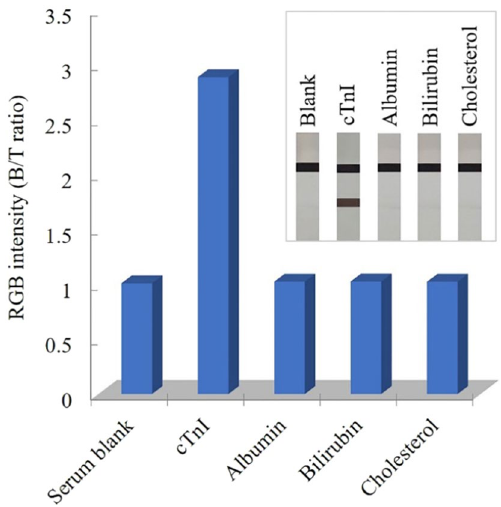
Figure 6. Bar graph and images of cross-reactivity test after silver enhancement, assessing color intensity of B/T ratio of serum blank, cTnI, albumin, bilirubin and cholesterol.